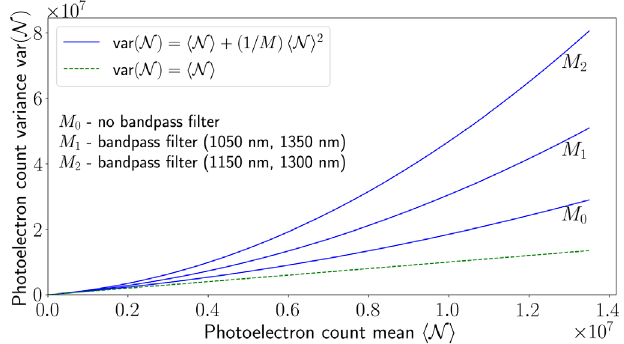
FIG. 5. Simulations for photoelectron count variance in IOTA for three different filter configurations. The green dashed line represents the photon shot noise contribution to the